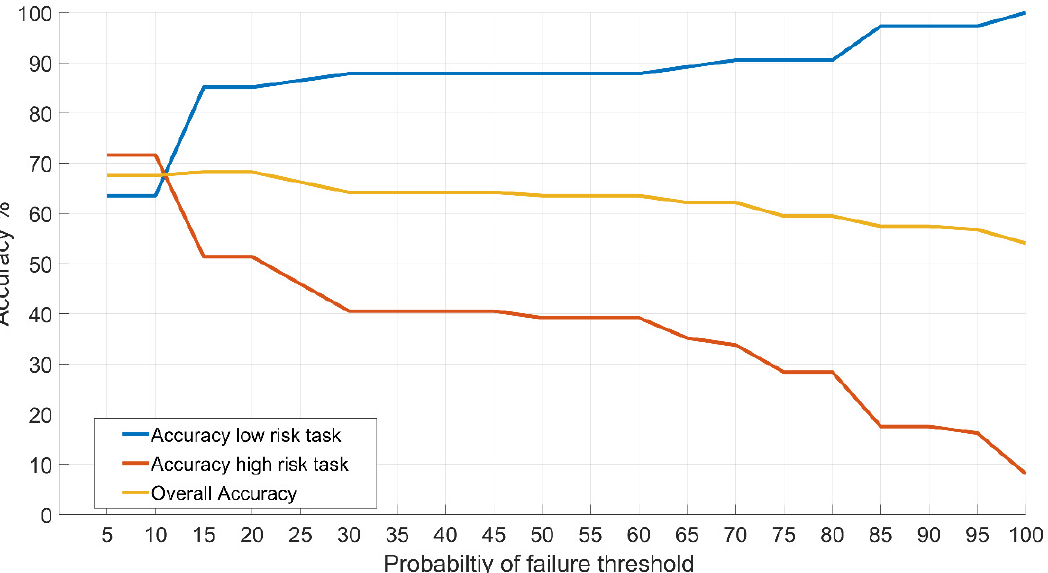
Figure A1 . Overall accuracy, classification accuracy for low-risk tasks, and classification accuracy for high-risk tasks for different probability-of-failure thresholds.